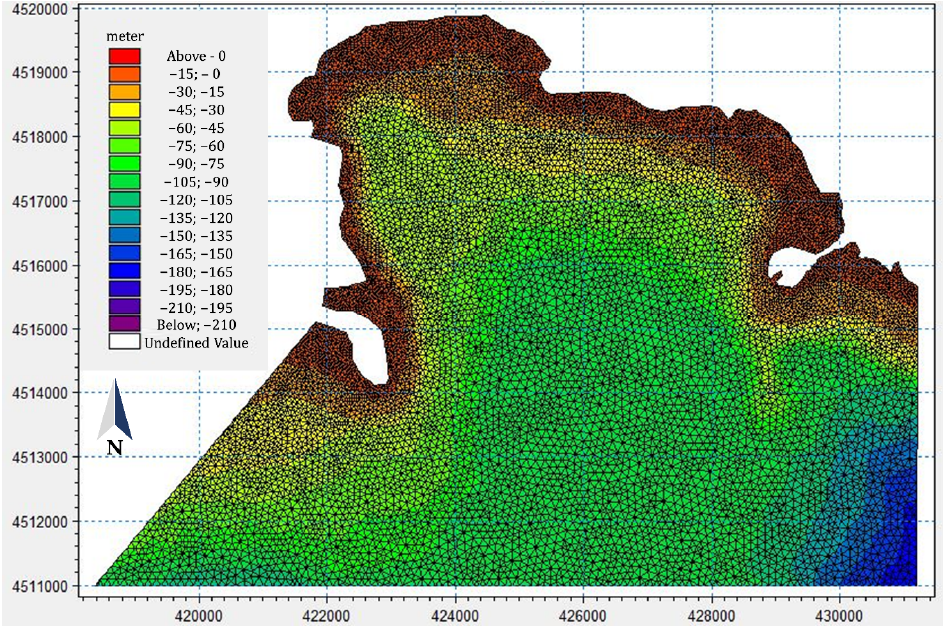
Figure 8. Zoom on the Bagnoli-Coroglio Bay with focus on the computational mesh implemented in MIKE 21 SW: MIKE 21